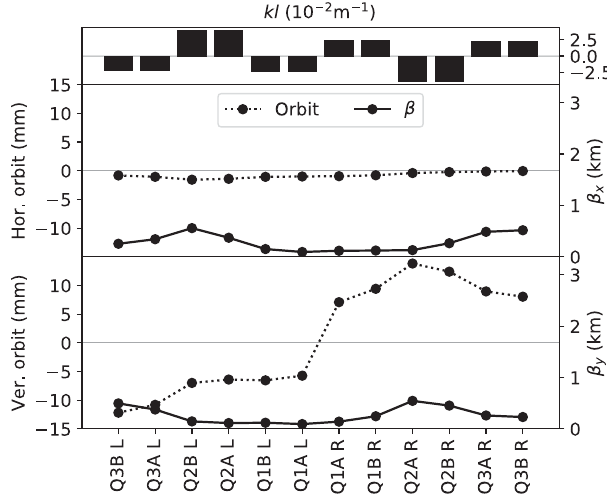
FIG. 5. Integrated quadrupolar strength ( kl ), orbit and β - functions across the triplet of IR1 with injection